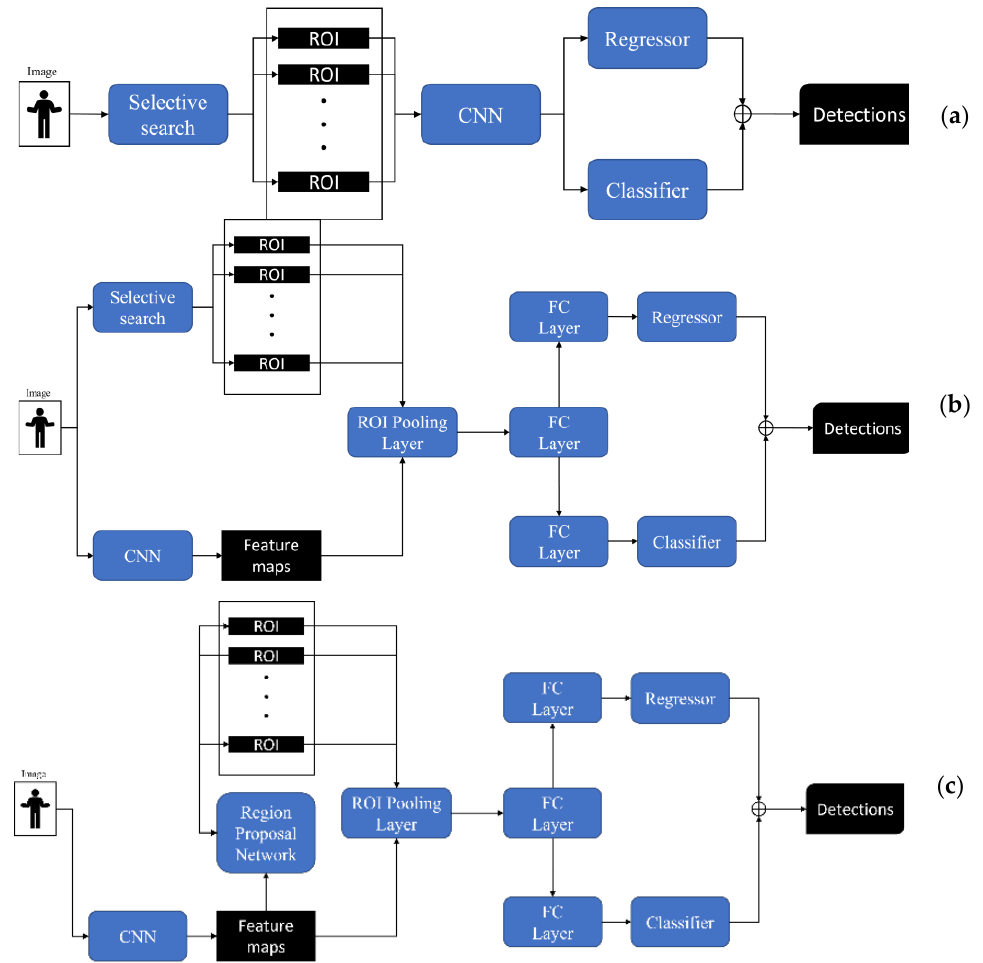
Figure 3. Network flows schematics ( a ) R-CNN, ( b ) Fast R-CNN, ( c ) Faster R-CNN.